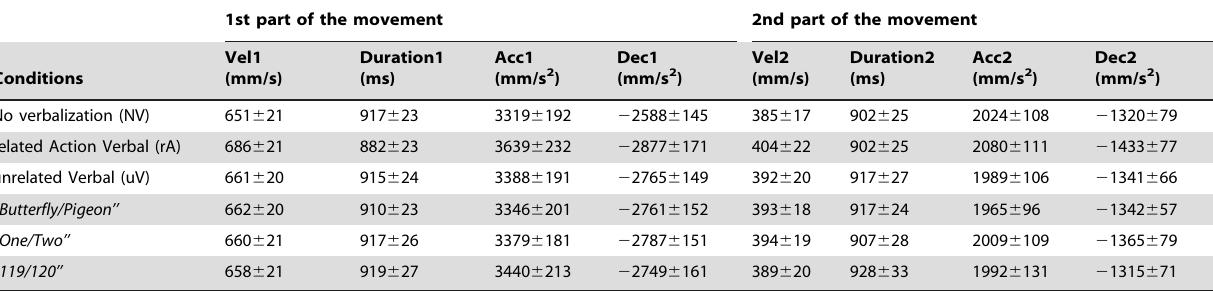
Table 1. Experiment I: Averaged values for all analysed parameters for each